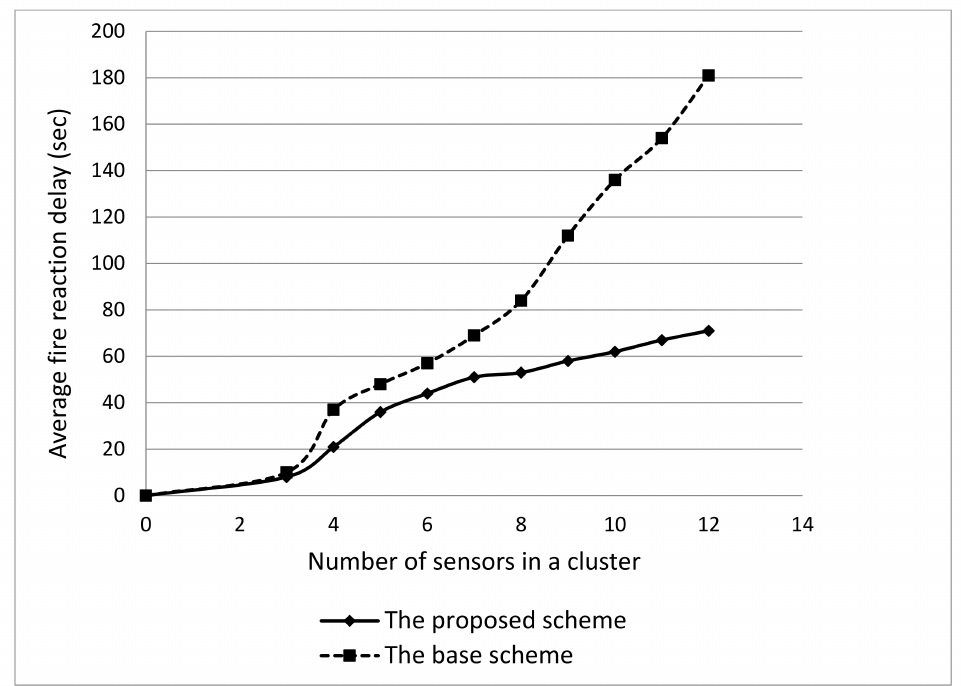
Figure 9. Average fire reaction delay of the proposed and base schemes with the various cluster